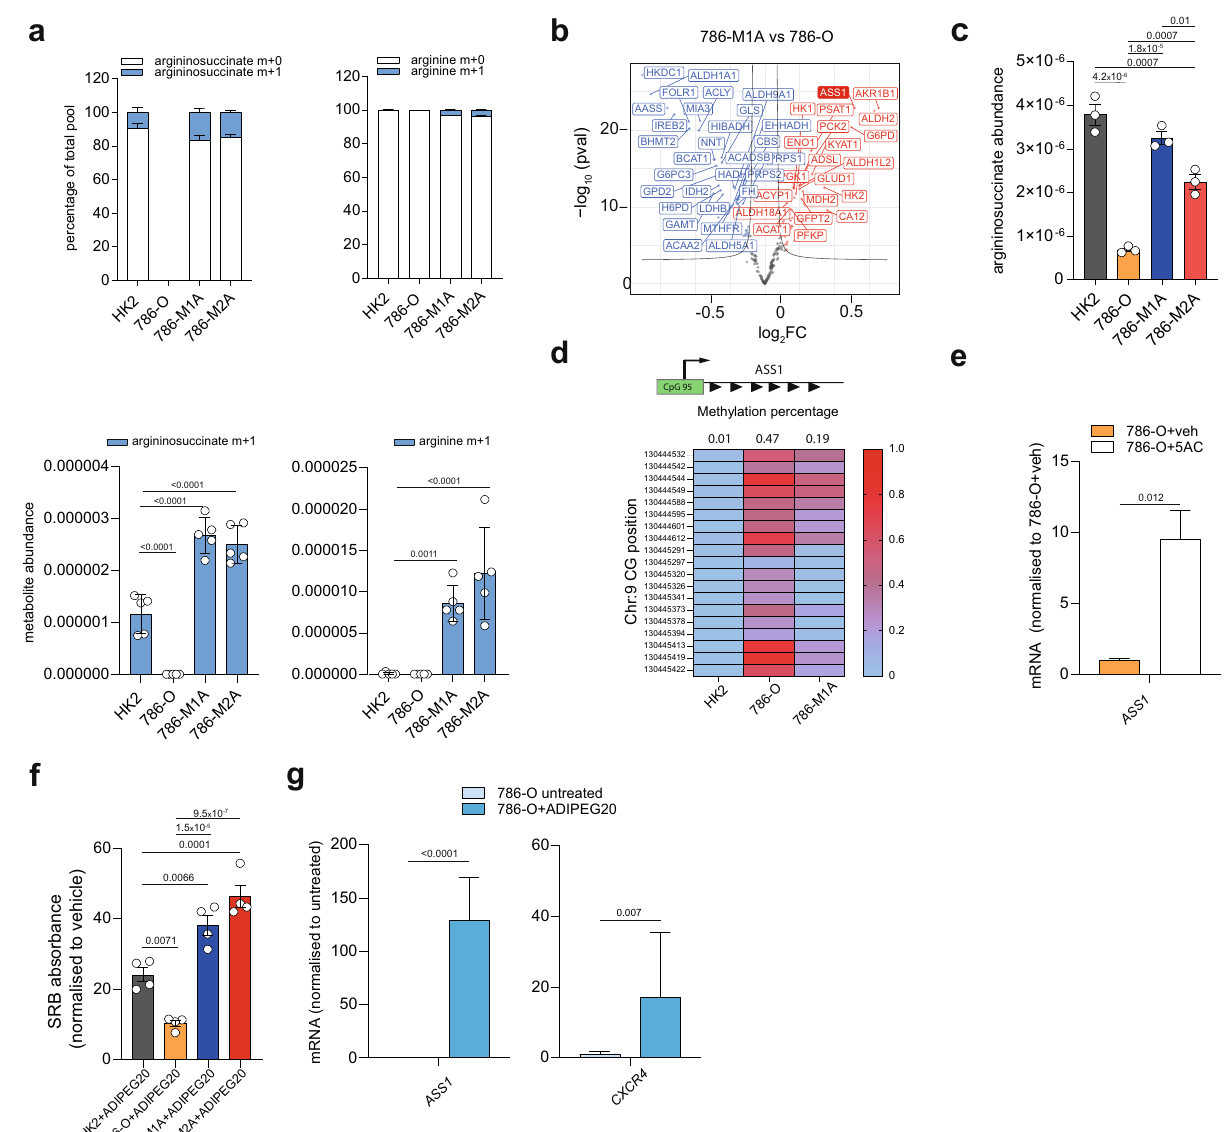
Fig. 6 | ASS1 re-expression in metastatic ccRCC confers resistance to arginine depletion. a Proportion of the total pool of the indicated labeled metabolites originatingfrom 15 Nleucine(top)andabundanceoflabeledleucinem+1,glutamate m+1, aspartate m+1 (bottom) after 27h normalized to total ion count. Data repre- sent the mean of 6 independent cultures±SD. p -values were calculated using one- way ANOVA where each group was compared with HK2. b Volcano of the differ- entially regulated metabolic genes comparing 786-M1A vs. 786-O using RNA-seq data generated from cells grown in Plasmax. redindicates upregulated genes, bluedownregulated genes. FC fold-change. c Argininosuccinate abundance in the indicated cell lines cultured in Plasmax measured using LC – MS. Data were nor- malized to total ion count and represent the mean of 3 independent experiments ( N =3)±S.E.M. p -values were calculated using one-way ANOVA with multiple comparisons. d Heatmap of the methylation level ( B -value) of the indicated CGs withinaCpGislandoverlappingwith ASS1 TSS.Valuesarepresentedasthemeanof twoindependentexperiments( N =2).TheaverageofallCGsmethylation b -valueis reported on top the heatmap for each cell type. e mRNA levels of ASS1 in 786-O